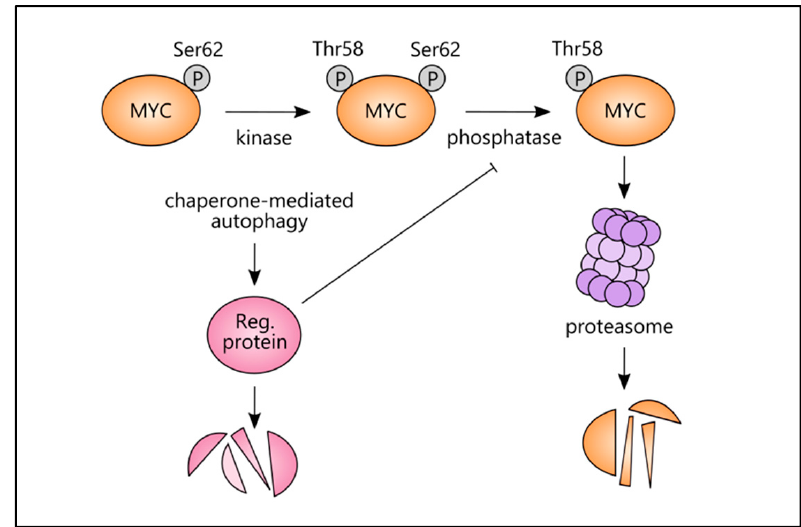
Figure 5. CMA and MYC protein stability. A phosphatase removes phosphoserine 62 from MYC, rendering it unstable and susceptible to proteasomal degradation. This phosphatase may be suppressed by a regulatory protein (e.g., CIP2A) that can, in turn, be degraded by CMA-associated processes. Reg. = regulatory.